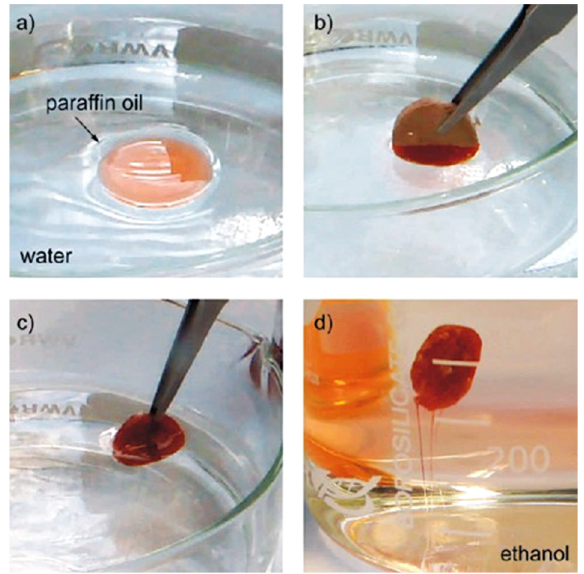
Figure 5. Oil spill removal from water. Paraffin oil (colored for clarity) floating on water ( a ); oil being absorbed into the aerogel ( b ); all of the floating oil has been absorbed ( c ); oil-filled aerogel can be washed simply by immersing it in a solvent such as ethanol. The oil is removed as shown by the red streaks ( d ). Reprinted with permission from [ 159 ] . Copyright 2010 American Chemical Society.